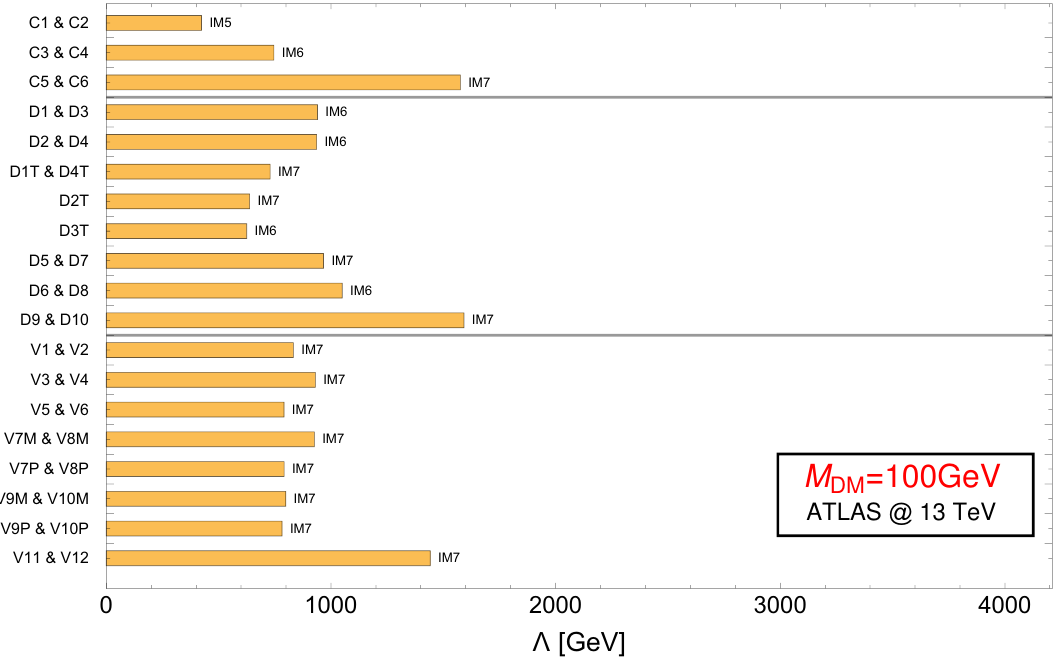
Λ [ GeV ] Figure 10 . Observed limits on the UV cut-o(cid:11) (cid:3) from the ATLAS search of ref. [3] using 13 TeV data with a luminosity of 3.2 fb (cid:0) 1 . See the caption of (cid:12)gure 9 for more details about the interpretation of the